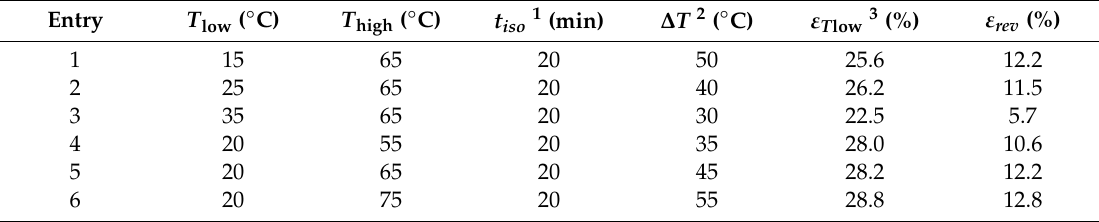
Table 4. Bidirectional actuation of PEUU foam under constant load conditions ( σ = 16.8 kPa) for different temperature ranges.